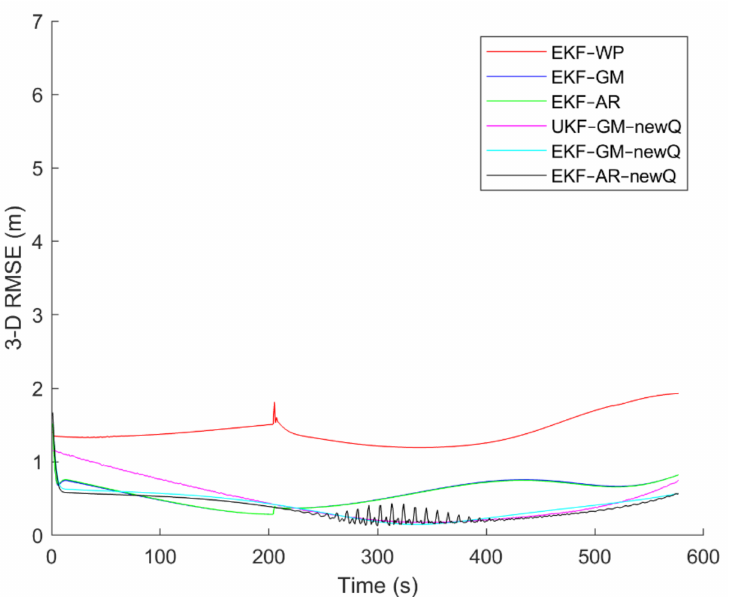
Figure 21. The positioning error of different methods in the sixth